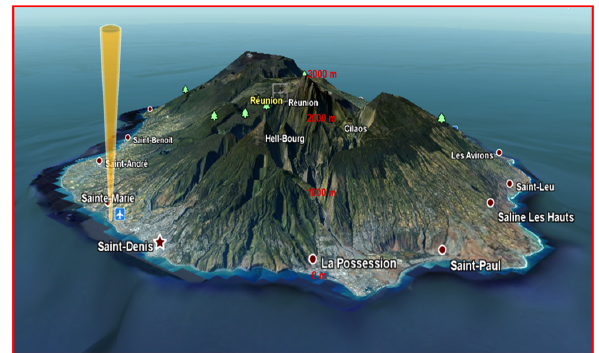
Fig. 1. Topography of Réunion. The UHF wind profiler is located at Saint-Denis Airport (20 ◦ 53 0 33 00 S, 55 ◦ 31 0 44 00 E). Red circles in- dicate the locations of principal cities.